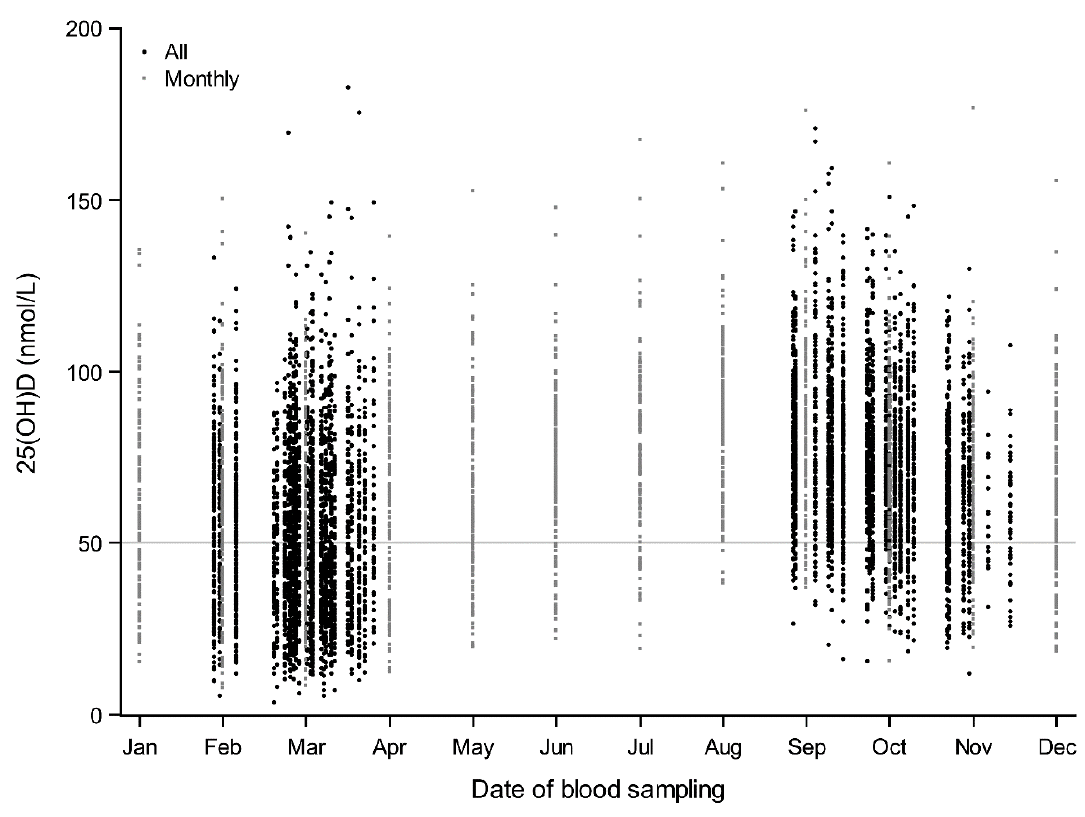
Figure 1. Seasonal variation in serum 25-hydroxyvitamin D (25(OH)D) concentrations among all participants (black dots; n = 3092) and only monthly participants (small gray squares; n = 167).